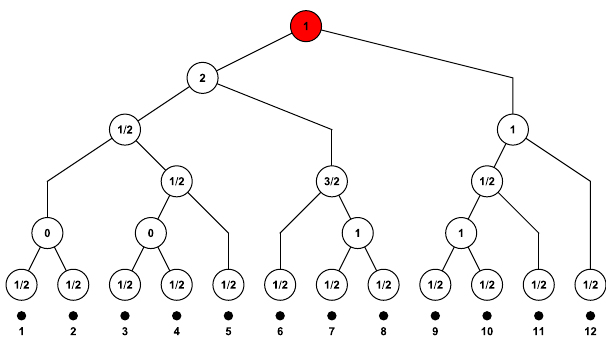
FIG. 2. A multiplet of eigenstates predicted by the SDRG for a system of 12 spins 1 = 2 . The leaves of the tree represent elementary spins in the system. The tree describes the way the elementary spins are fused into larger block spins in the course of the SDRG. The numbers in the nodes indicate the resulting spins of the blocks. The value in the top node (marked red) is the total spin S 0 of the system ( S 0 ¼ 1 in the present example). S 0 is an exact integral of motion. ð 2 S 0 þ 1 Þ different states in the multiplet can be distinguished by additionally specifying the projection of the spin in the top node to the z